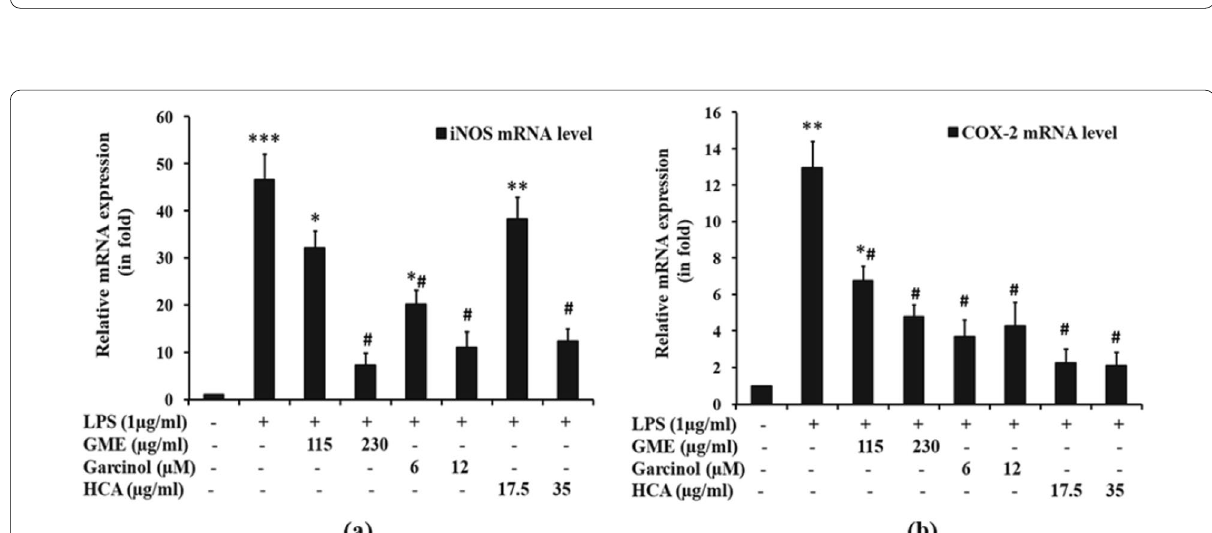
Fig. 8 Effects of GME, Garcinol and HCA on the mRNA expression levels of a inos and b cox-2 in LPS-stimulated RAW264.7 cells . Cells were pretreated with GME (115 µg/ml and 230 µg/ml); Garcinol (6 µM and 12 µM); HCA (17.5 µg/ml and 35 µg/ml) before LPS (1 μg/ml) stimulation followed by 24 h incubation. Total RNA was extracted and analyzed by real-time qPCR. Levels of inos and cox-2 transcripts in the experimental groups are expressed as fold-changes relative to control group after being normalized against gapdh standard. The data represented are the mean SEM. * p < 0.05, ** p < 0.01, *** p < 0.001 vs. the control group; # p < 0.05, ## p < 0.01, ### p < 0.001 vs. the LPS ±